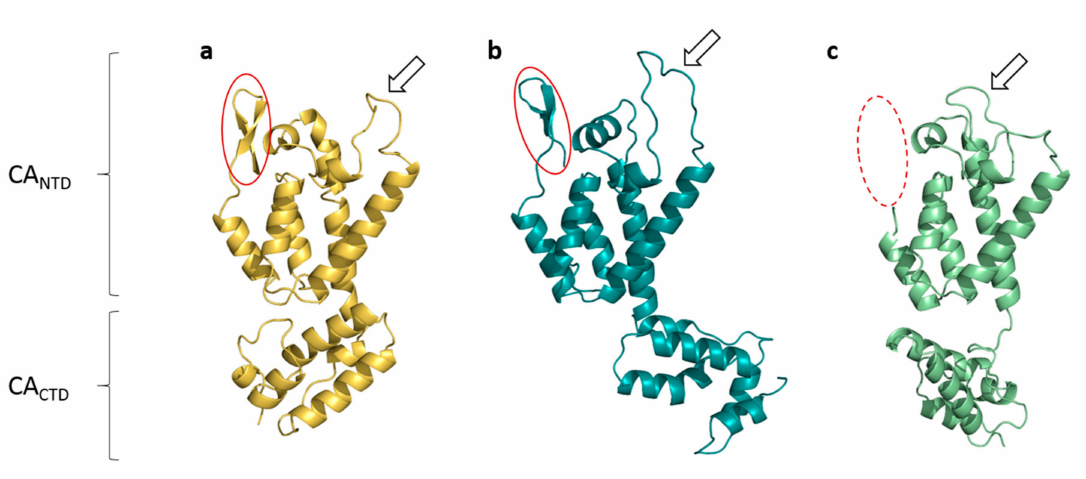
Figure 3. Structural comparison of retroviral capsid protein: ( a ) FIV in yellow; ( b ) HIV-1 in teal (PDB ID: 3NTE [43]) and ( c ) EIAV in green (PDB ID: 2EIA [22]). β -hairpins are circled in solid red when present, in dotted red when not visible in the structures; CypA-BLs are shown with an arrow.